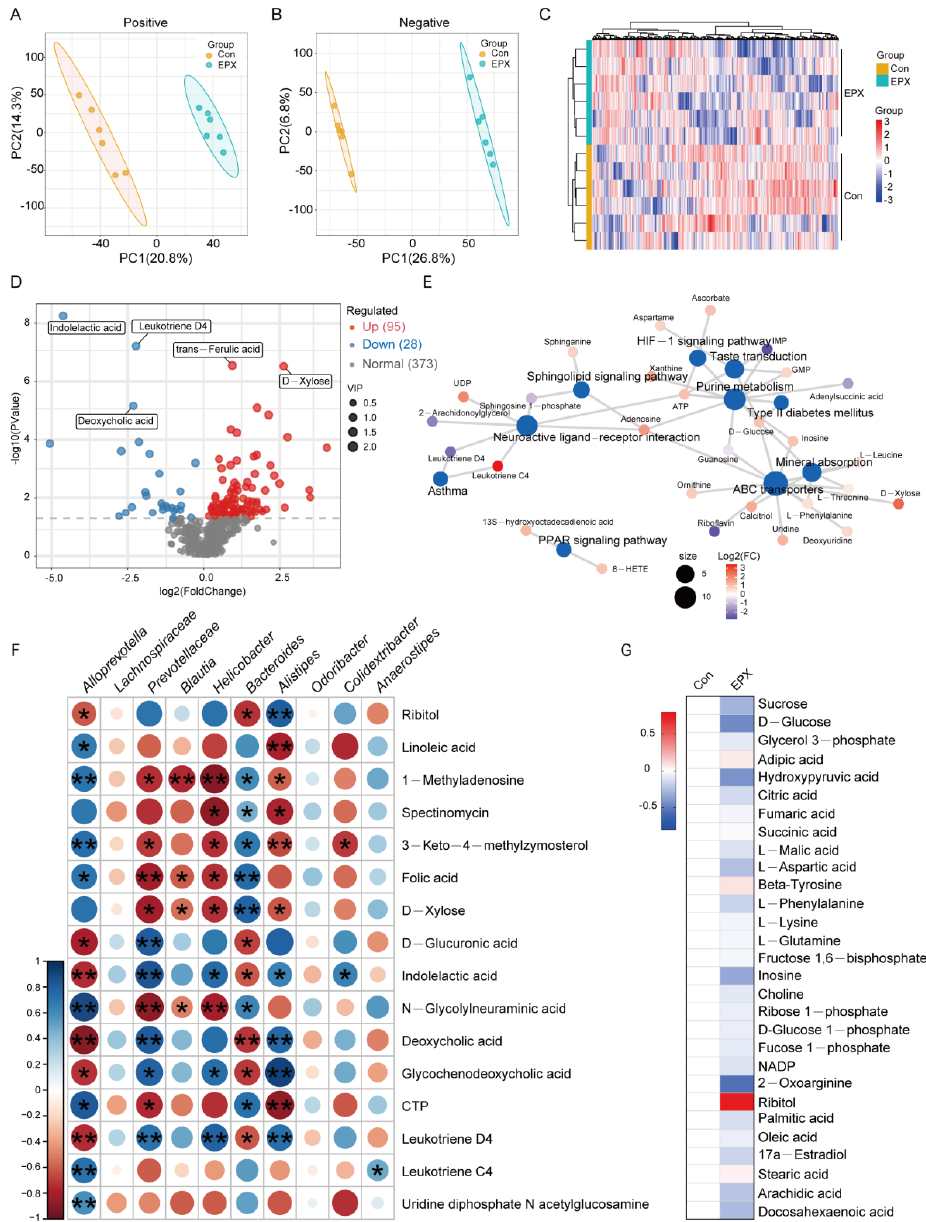
Figure 5. Effects of oral exposure to EPX on the metabolic profiles of the liver in mice. ( A , B ) PCA of metabolites in positive and negative ion mode. ( C ) Heatmap of DEMs. ( D ) Volcano map of DEMs. ( E ) Concept network of the KEGG pathway analysis for DEMs. ( F ) The correlation between the top genera conducted with the Spearman’s rank test. ( G ) Carbohydrate and lipid metabolites. Significant correlation: p < 0.05 *; p < 0.01